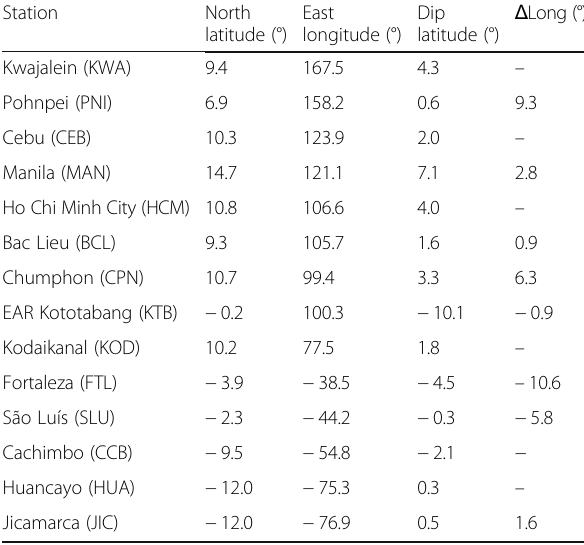
Table 1 Locations of Ionosondes and EAR Station